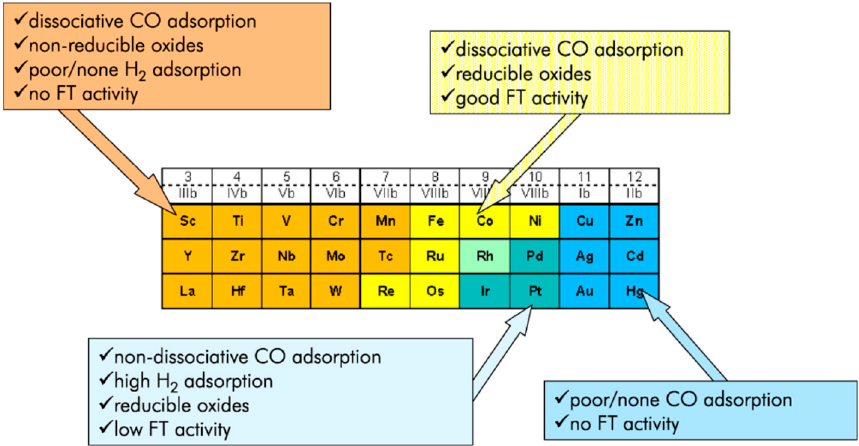
Figure 6. Behavior of transition metals towards the FTS reaction. Reprinted with permission from [12]. Copyright (2009) Elsevier Science BV, Amsterdam, The Netherlands.